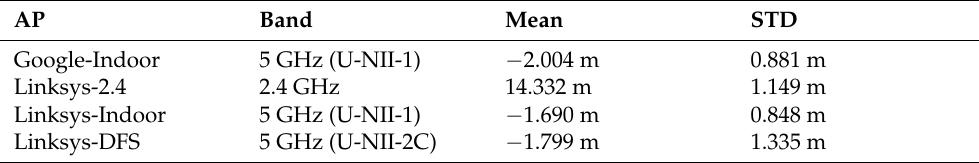
Table 4. Mean and standard deviation of the ranging error in the assessed scenarios. AP Band Mean STD Google-Indoor 5 GHz (U-NII-1) − 2.004 m 0.881 m Linksys-2.4 2.4 GHz 14.332 m 1.149 m Linksys-Indoor 5 GHz (U-NII-1) − 1.690 m 0.848 m Linksys-DFS 5 GHz (U-NII-2C) − 1.799 m 1.335